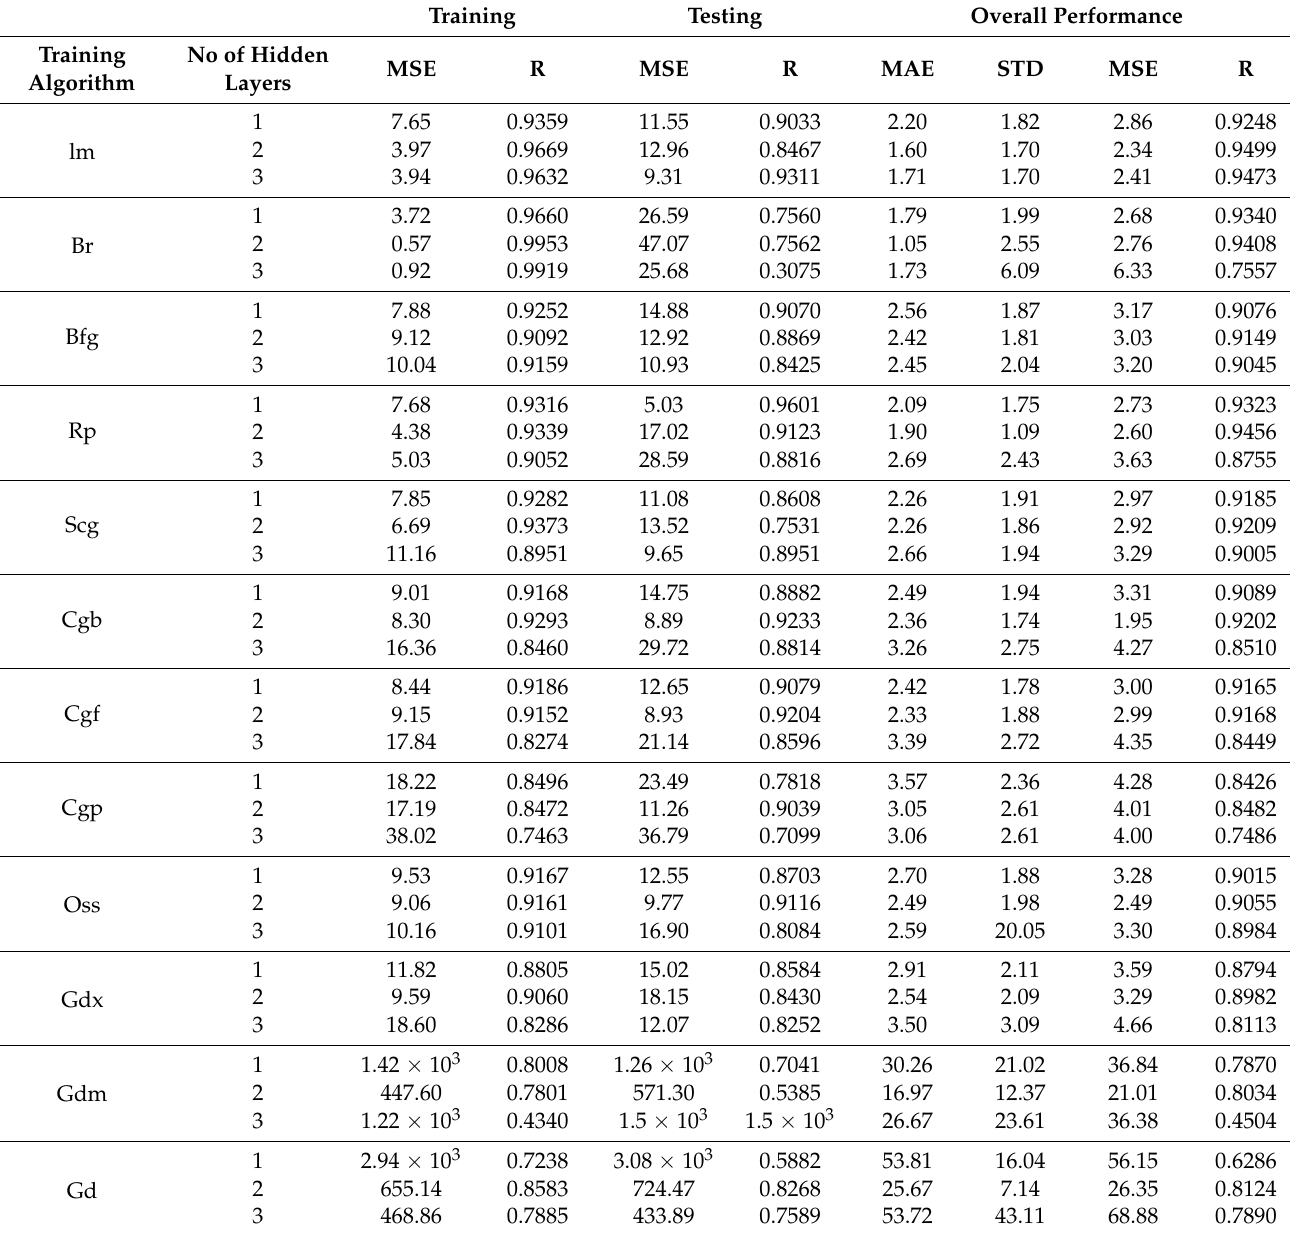
Table 5. Learning Algorithm and Hidden Layers Number impact on MLP